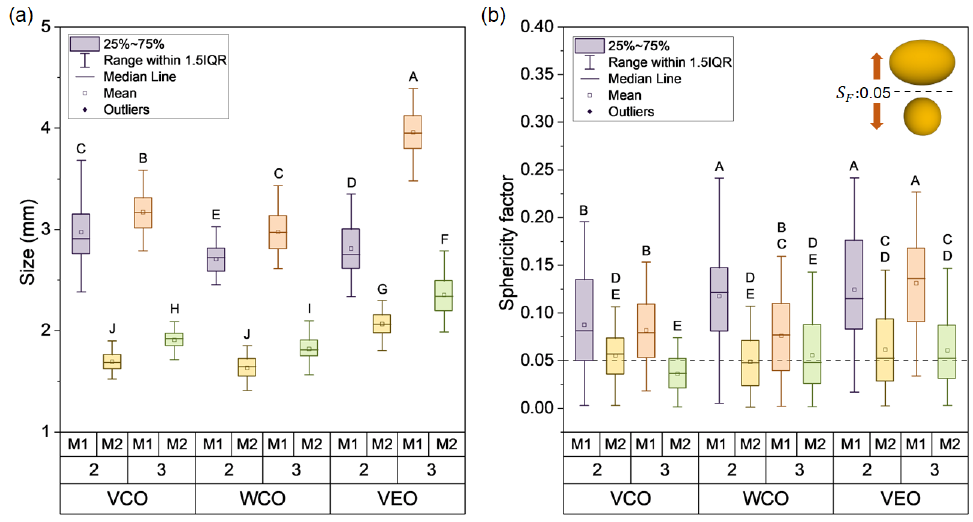
Figure 4. Box plot graphs for ( a ) the size and ( b ) sphericity factor of the different capsule designs.